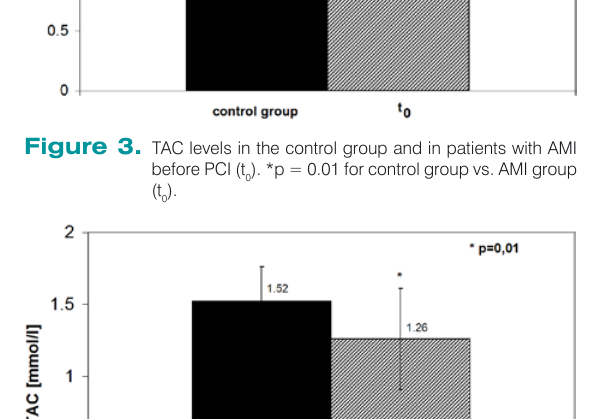
Figure 3. TAC levels in the control group and in patients with AMI